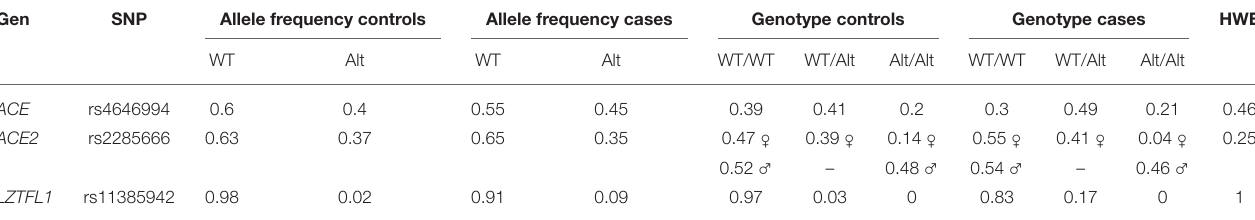
TABLE 4 | Allelic and genotypic frequencies for cases and controls.